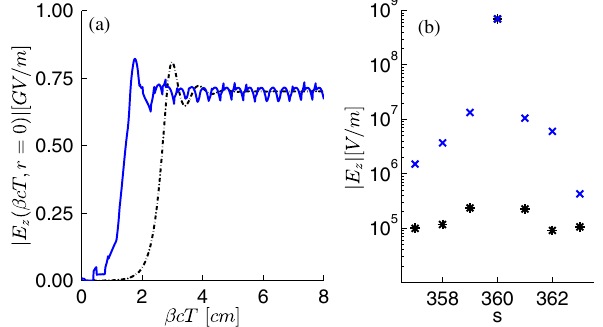
FIG. 9. (a) The wake dynamics for trigger bunch with M ð tg Þ ¼ 100 ; N ð tg Þ ¼ 2 . 8 × 10 7 (blue solid curve) and M ð tg Þ ¼ 10 ; N ð tg Þ ¼ 2 . 8 × 10 6 (black dashed-dot curve) in the length interval of 0 ≤ β cT ≤ 8 cm. In addition, each microbunch is a pointlike, namely, ψ ¼ 0 . (b) Comparison of the wake spectrum for M ð tg Þ ¼ 100 ; N ð tg Þ ¼ 2 . 8 × 10 7 (blue solid curve and blue crosses) with M ð tg Þ ¼ 10 ; N ð tg Þ ¼ 2 . 8 × 10 6 (black dashed-dot curve and black asterisks) at β cT ¼ 8